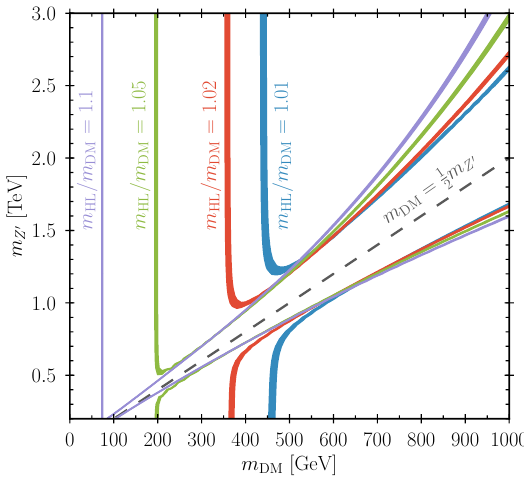
Figure 4 . Same as (cid:12)gure 3(b) for L 0 = 1 = 2, but including co-annihilation with the heavy leptons (cid:0) for (cid:1) m = 1 10%, assuming that e 4 , e 5 and (cid:23) 4 have equal mass m HL . The colored regions (cid:0)